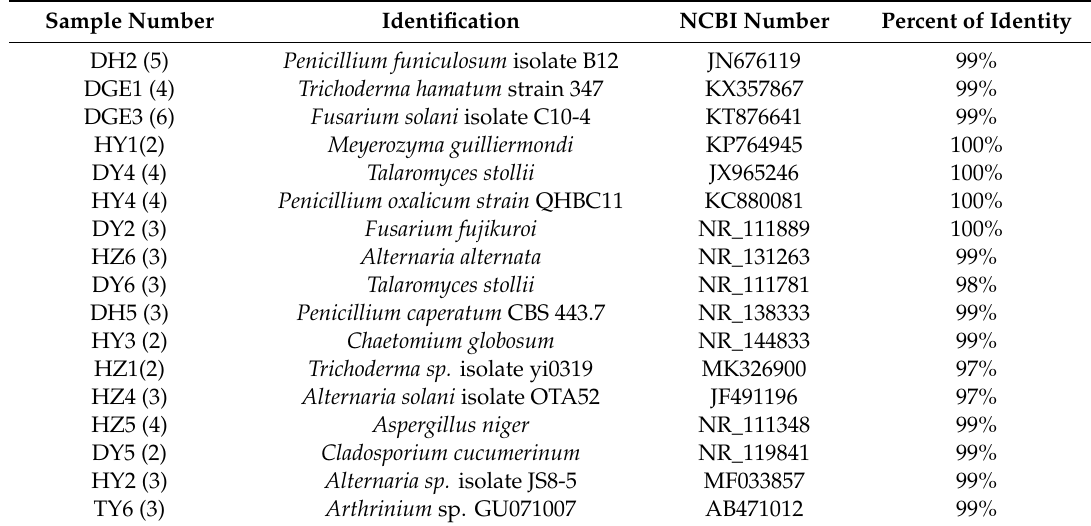
Table 2. Isolation of endophytic fungi of the Pinggu peach trees.